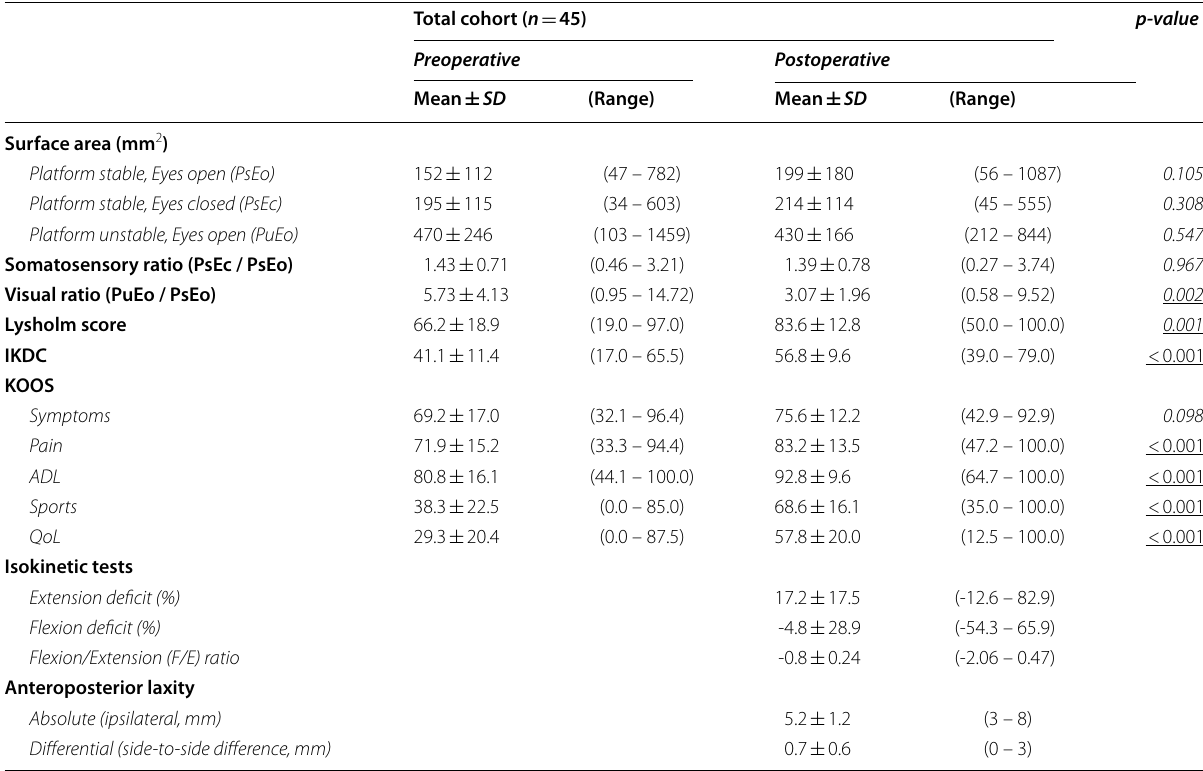
Table 2 Clinical outcomes